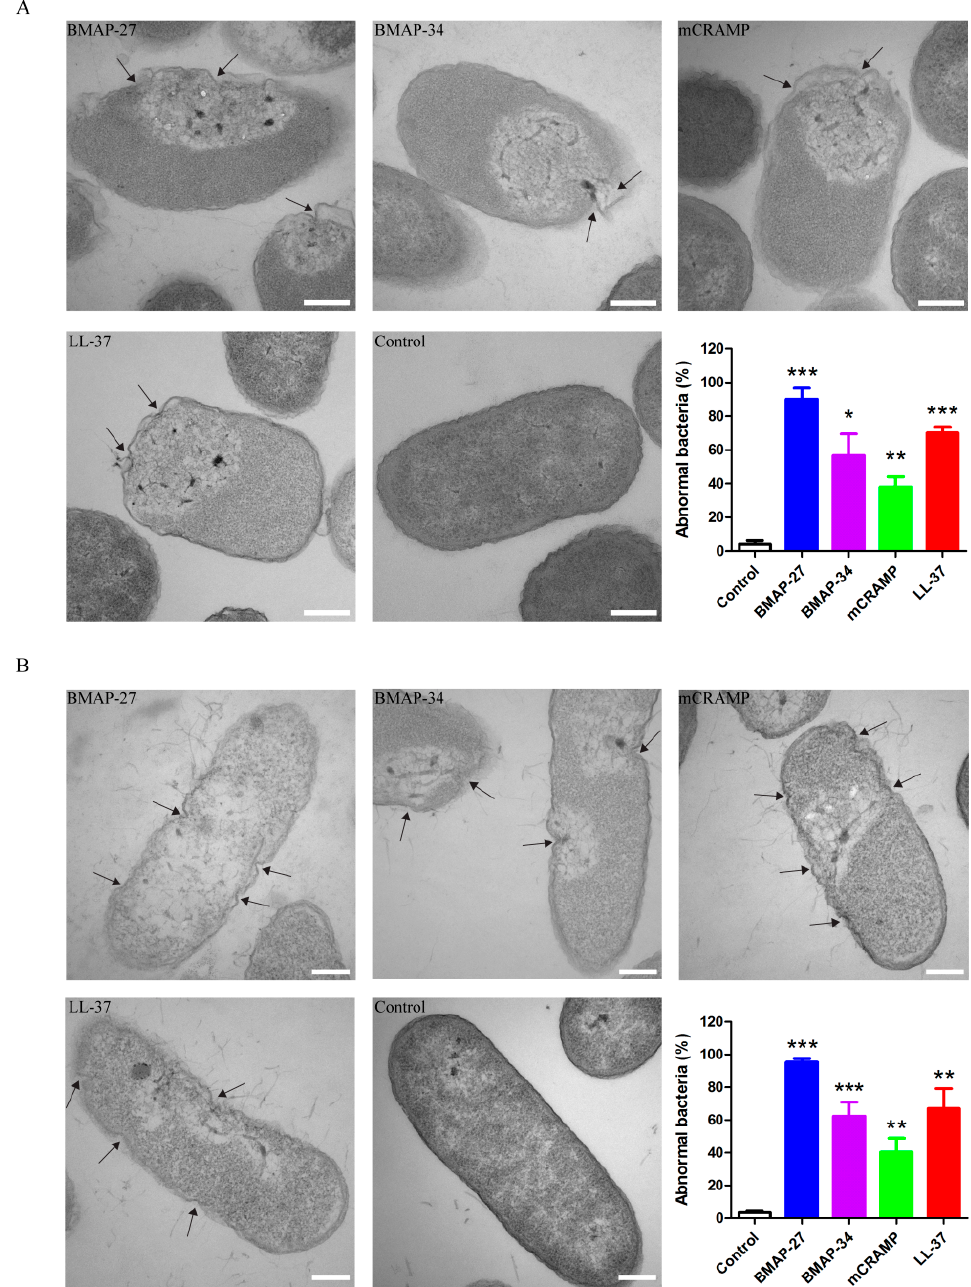
Figure 4. Mammalian cathelicidins disrupt the bacterial cell membrane. TEM of ( A ) E. coli and ( B ) P. aeruginosa in the mid-log phase at the treatment of BMAP-27, BMAP-34, mCRAMP, and LL-37 were carried out. All of the four peptides caused membrane damage, leading to varying degrees of lysed morphology and leakage of contents. The arrow indicates the sites of membrane damage. Scale bars = 200 nm. The percentages of abnormal cells after each peptide treatment are shown as mean ± SD from three independent counts and the number of cells for each count is 100 ( n = 100), * p < 0.05, ** p < 0.01, *** p < 0.001.